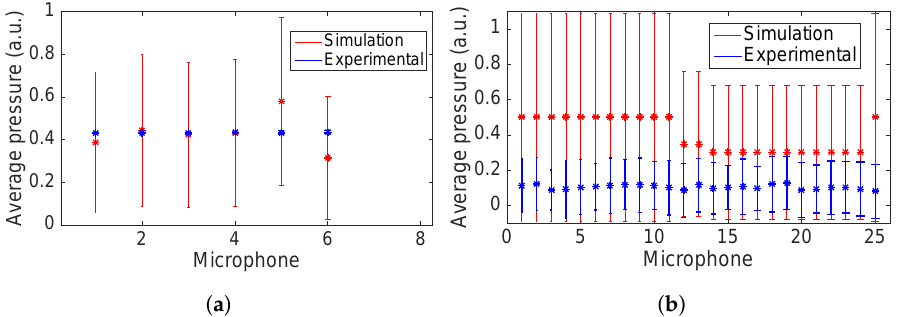
Figure 3. Time-averaged pressure validation against experimental measurements along ( a ) the VEGA fairing and ( b ) one of the masts. Results are normalized.